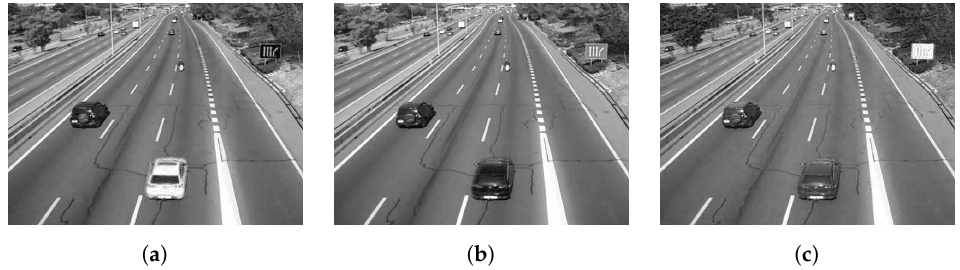
Figure 5. Current frame under ( a ) red mode ( I red